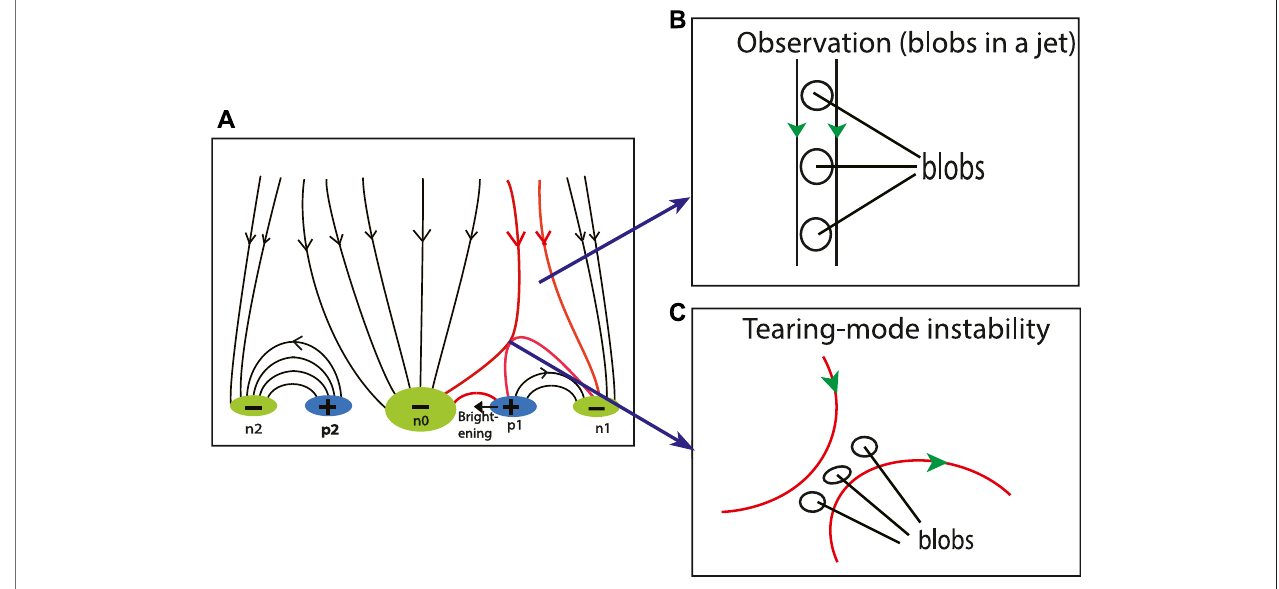
causes the different blobs velocities. Here the increased velocities refer to the different blobs at different time instants.